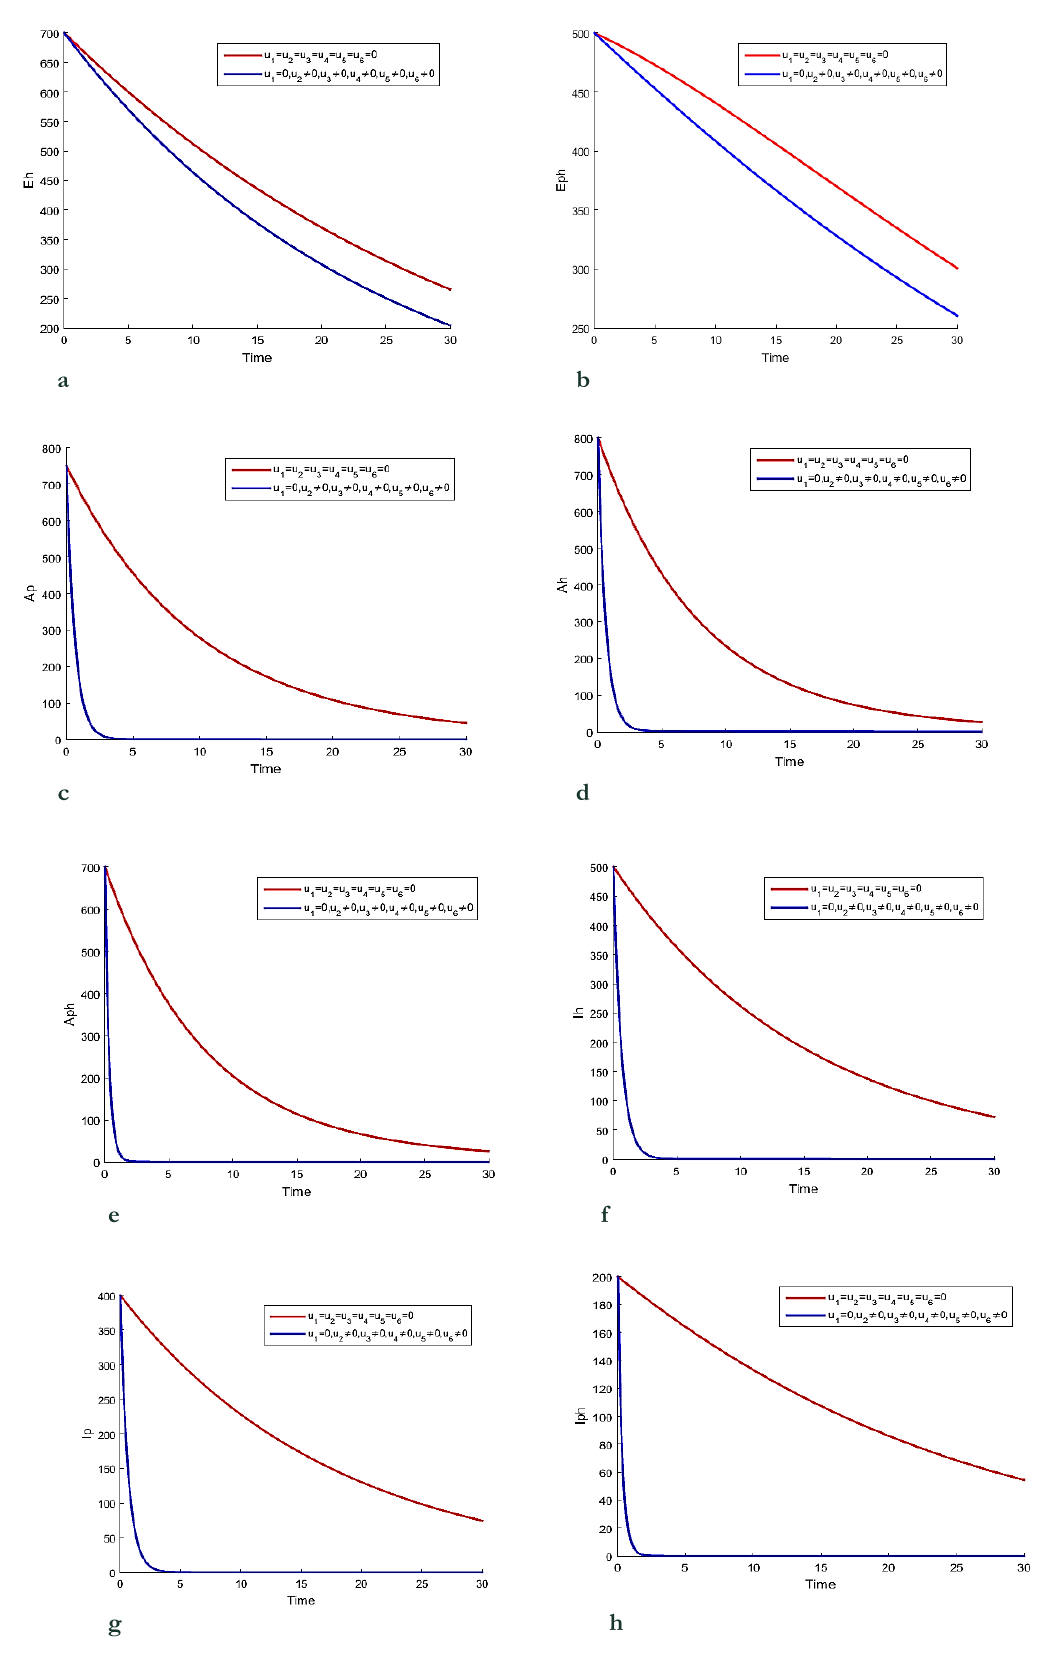
Fig 1. Simulations showing optimal use of 𝐮